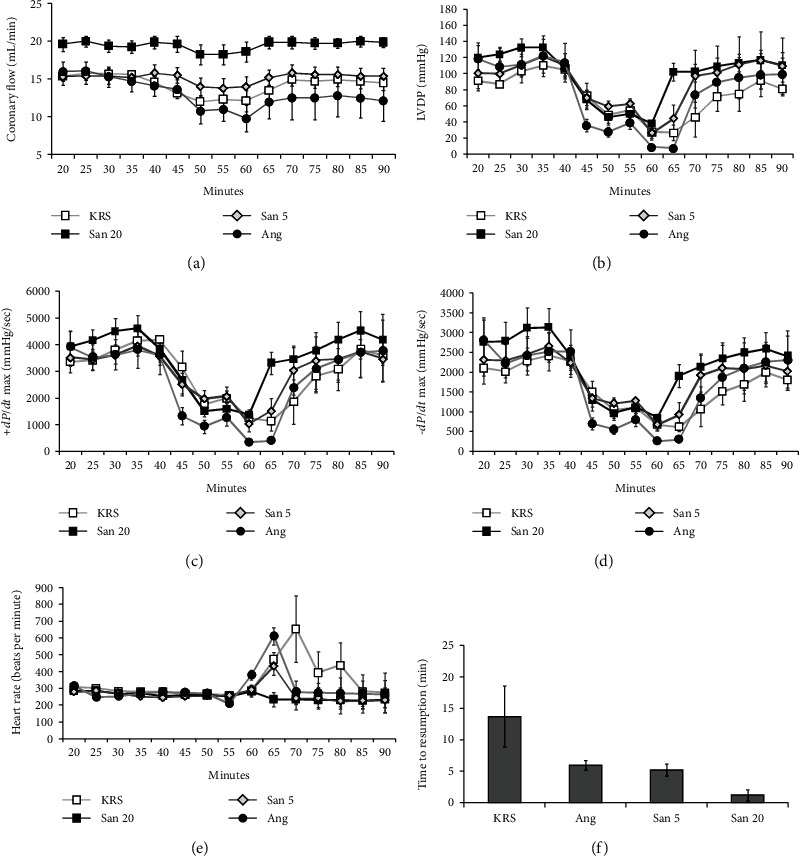
Comparison of coronary flow (a), LVDP (b), +dP/dtmax (c), −dP/dtmax (d), heart rate (e), and time to resumption (f) of rat hearts during warm ischemia experiments with four different treatments. These studies were performed with a period of 35 minutes of stabilization/perfusion, an interval of 15 minutes of regional ischemia, and following 30 minutes of reperfusion. Five different hearts were tested in each group (n = 5). The error bars represent the standard error of the mean in each group.